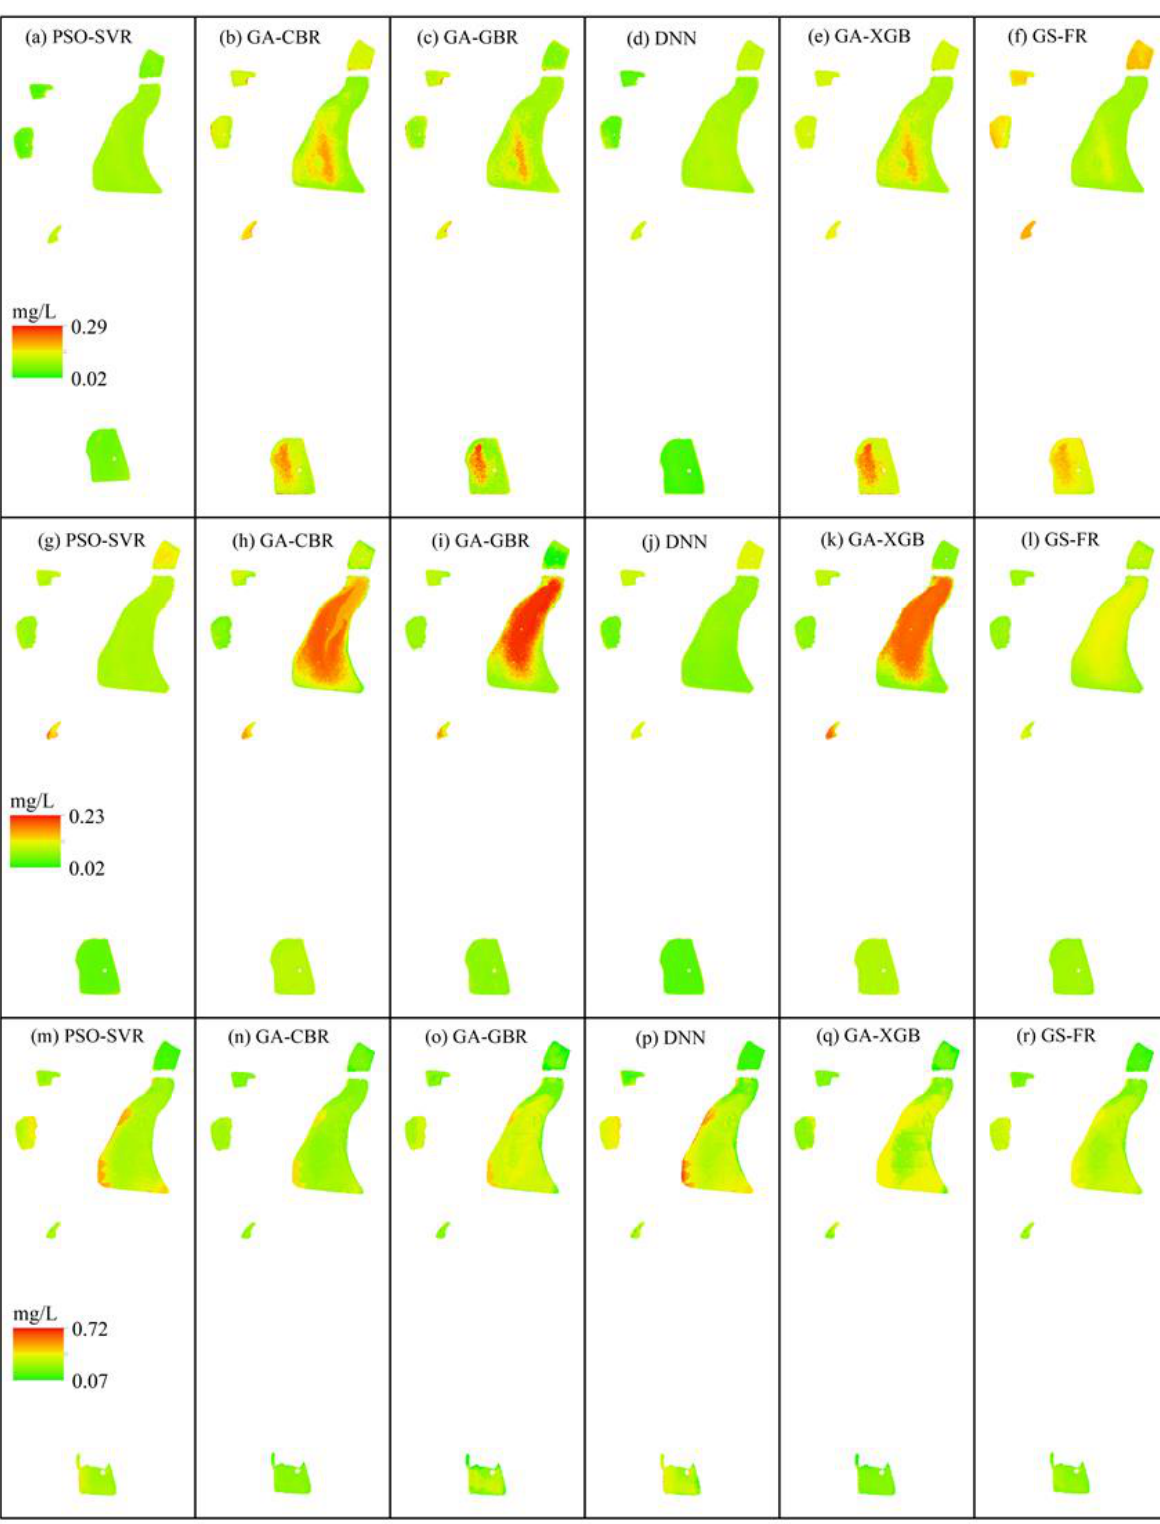
Figure 7. Spatial distribution of TP concentration derived from the six IOA-ML models in research area C on 10 December 2021 (first row ( a – f )), 27 May 2022 (second row ( g – l )), and 27 September 2022 (third row ( m – r )), and every day has the same legends represented in ( a , g , m ), respectively.